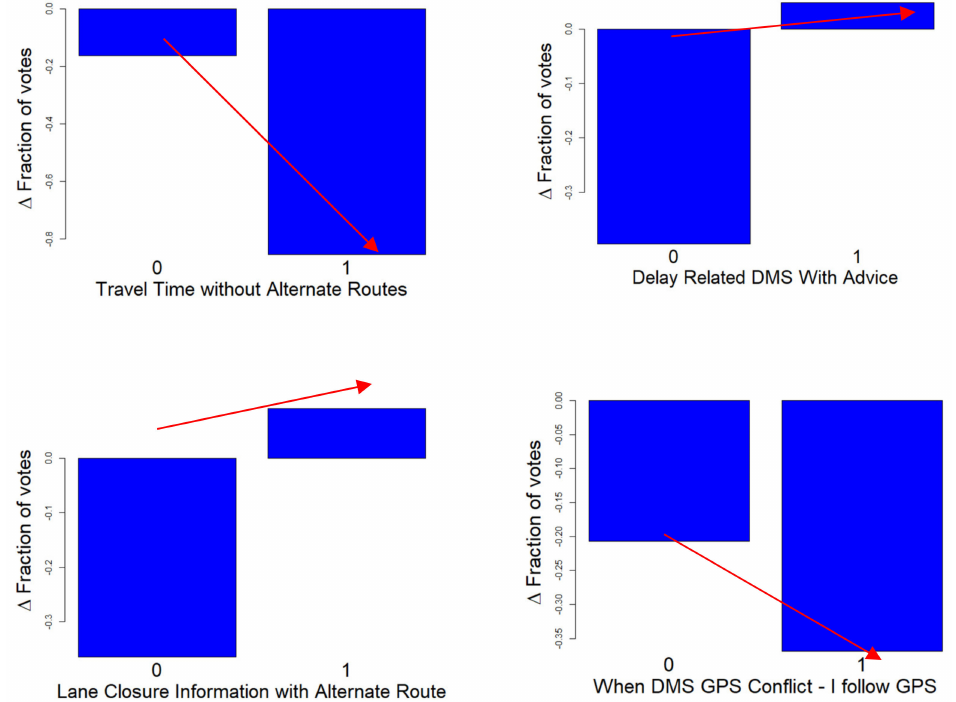
Figure 8. Partial dependency plots (PDPs) of important variables impacting diversion behavior (the direction of the trend is shown by the red